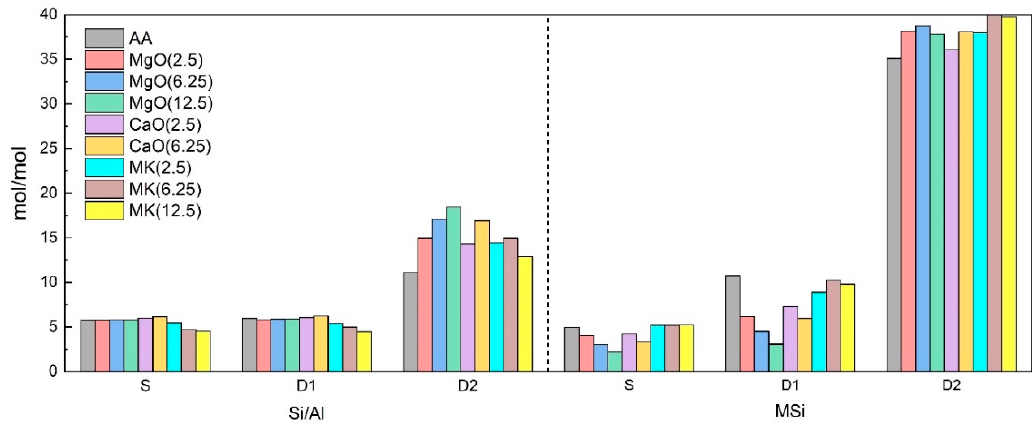
Figure 2. Si / Al ratio and M Si parameter of Figure 2. Si/Al ratio and M Si parameter of samples.